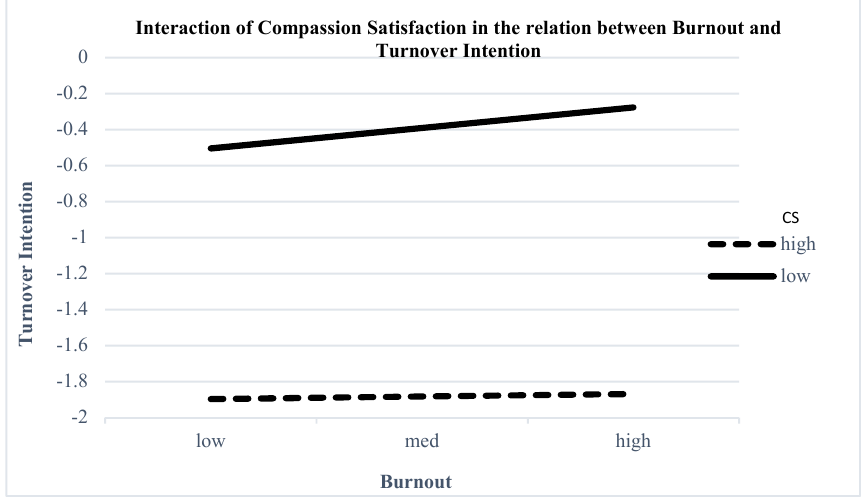
Figure 1. Interaction of Compassion Satisfaction in the relation between Burnout and Turnover In- tention.